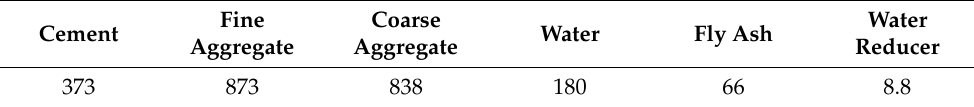
Figure 8. The main process of the F – T segments. ( a ) Details of a segment. ( b ) Preparation before pouring. ( c ) Pouring concrete of segment. Table 5. The mixed proportions of concrete (kg/m 3 ).